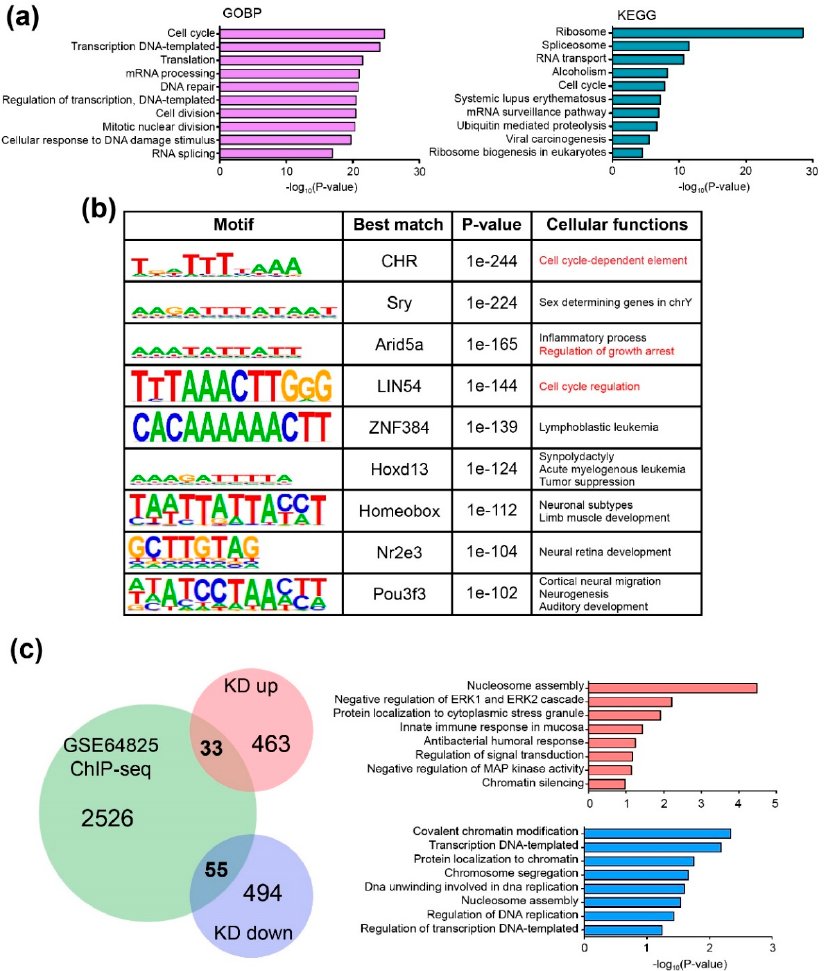
Figure 4. CHD9 binds directly to genes controlling the cell cycle. ( a ) Gene ontology (GO) term analysis for ChIP-seq data (GSE64825) for biological processes (BP) and KEGG. ( b ) De novo motif analysis of CHD9 ChIP-seq data showing the top nine significant motifs and best-matched transcription factors that bind to the motifs. Predicted cellular functions are shown. Cutoffs made by p -value < 1e-25. ( c ) Venn diagram and GO term analysis for the identified common genes between ChIP-seq data and DEGs showing 33 genes commonly upregulated and 55 genes commonly downregulated. − log 10 ( p -value) was used.